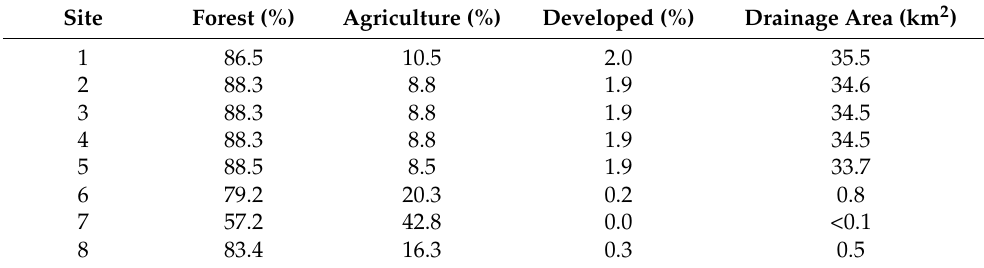
Table 1. Land use/land cover characteristics (% cover) and total drainage area (km 2 ) at eight sub-basin monitoring sites comprising an experimental watershed study in Moore’s Run Watershed, WV,